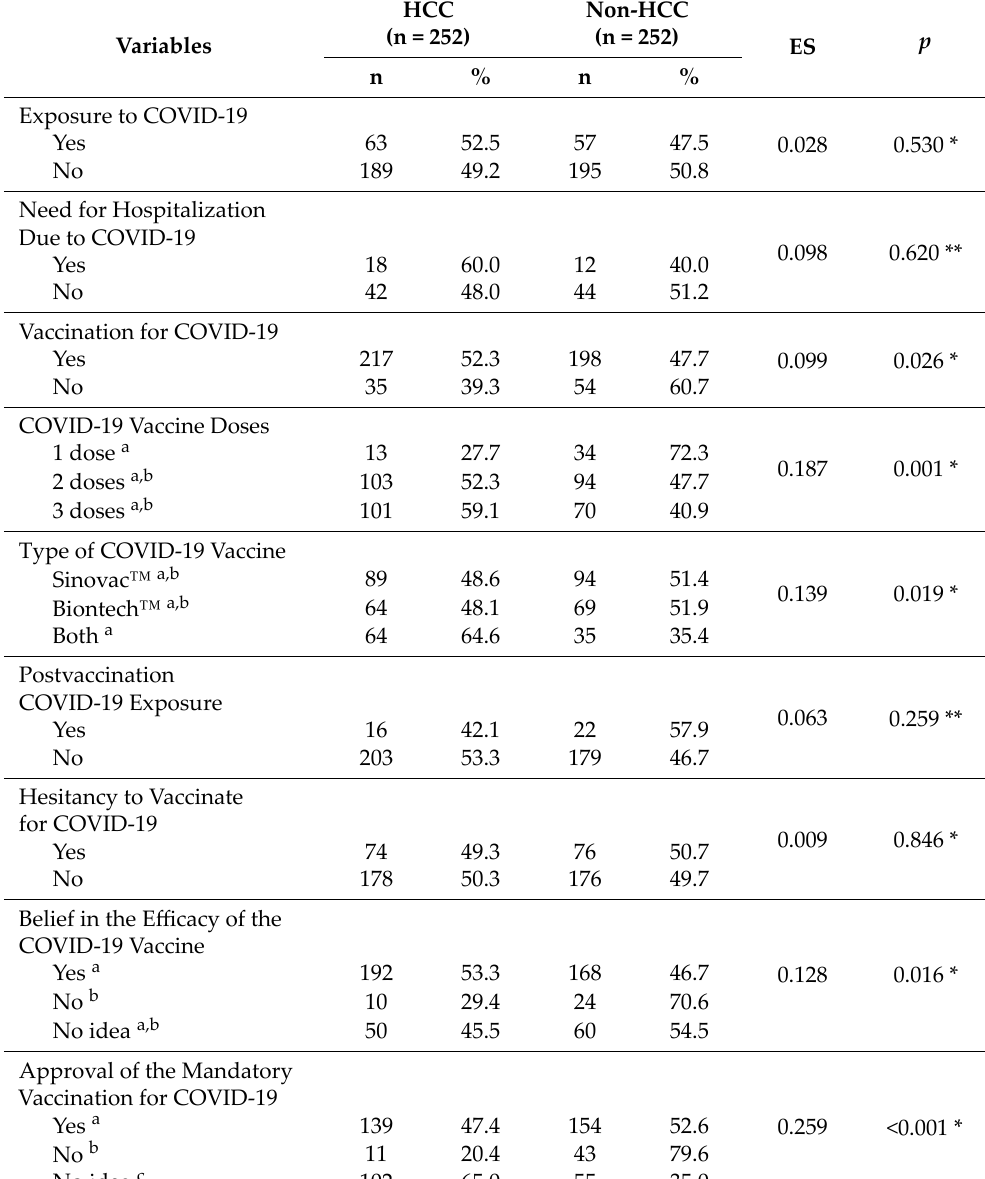
Table 2. Comparison of the groups in terms of COVID‑19‑related